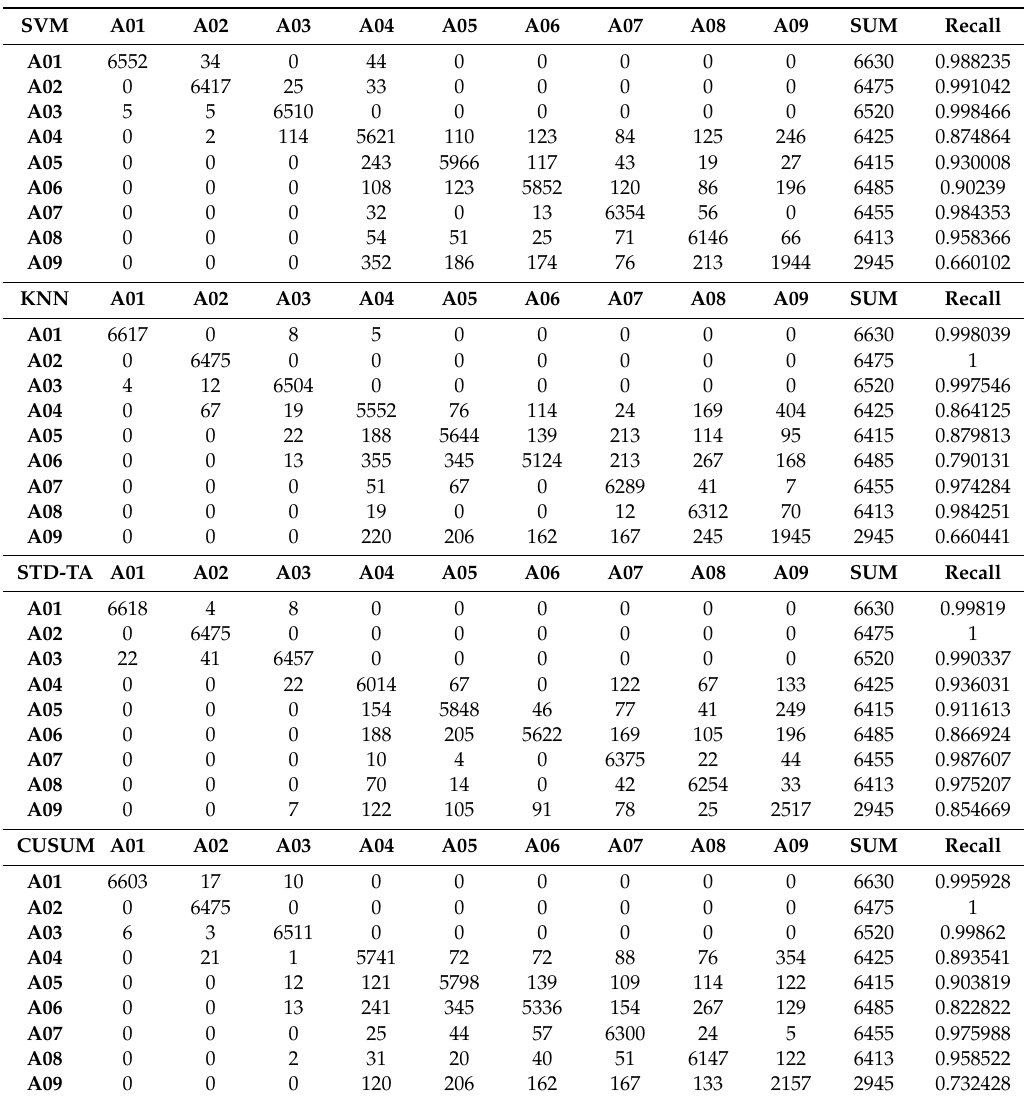
Table 6. Overall performance of four